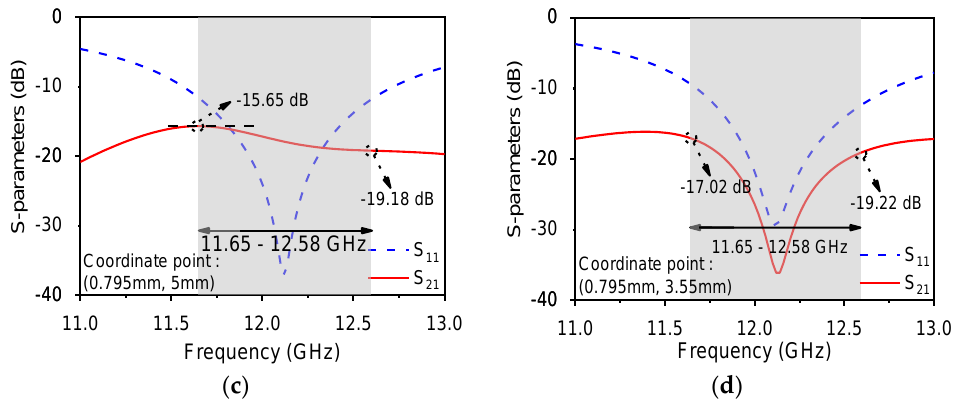
Figure 4. Simulated S − parameters of path − monopole antenna array with different coordinate points of feed probe. ( a ) (1.275 mm, 5 mm); ( b ) (1.075 mm, 5 mm); ( c ) (0.795 mm, 5 mm); and ( d ) (0.795 mm, 3.55 mm).